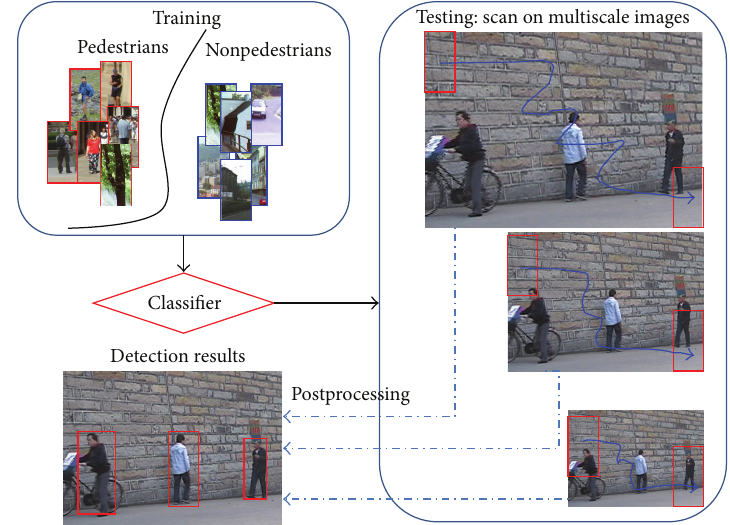
Figure 7: Framework of the proposed HIKSVM-based pedestrian detection with sliding window